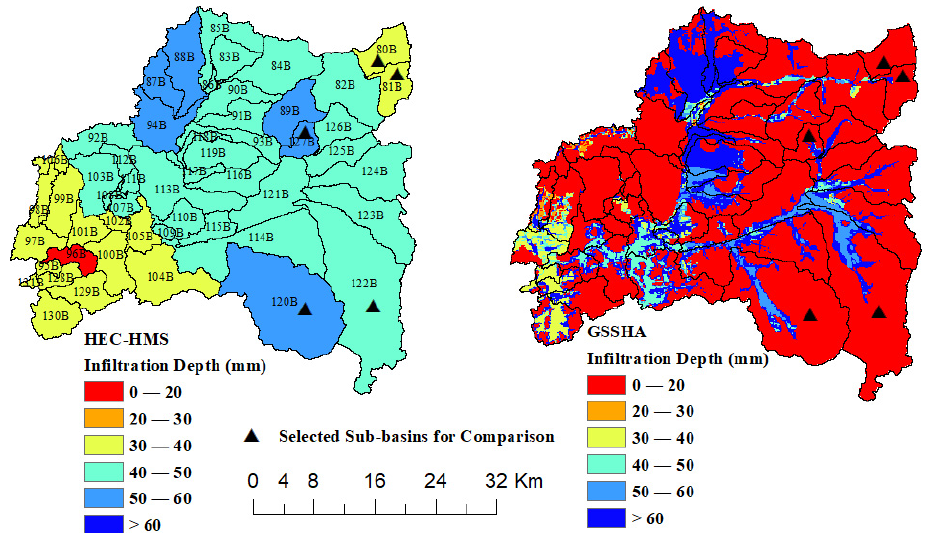
Figure 16. Spatial distribution of cumulative infiltration depths (m) based on HEC-HMS and GSSHA for the 2010 storm event. Table 3. Comparison between GSSHA as a reference and HEC-HMS outputs at selected locations.